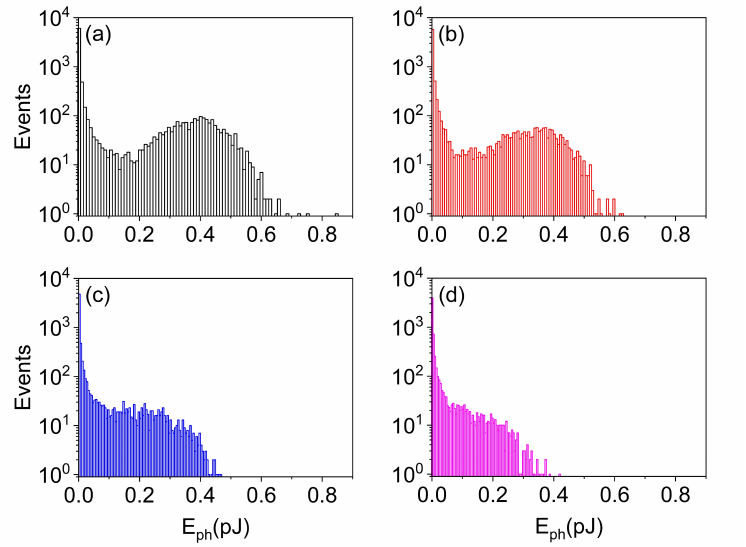
Figure 7. Histogram of energy distribution for feedback fractions η = : 0.005 ( a ); 0.01 ( b ); 0.05 ( c ); and 0.1 ( d ), respectively. Pump: P = 1.6 P th ; P = 1.5 P th ( b ); P = 1.3 P th ( c ); and P = 1.15 P th ( d